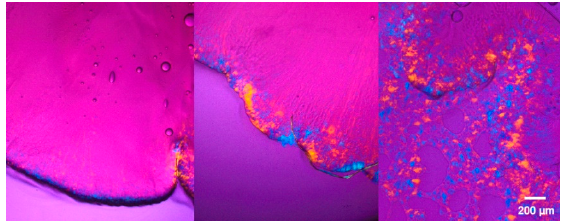
Figure 4. Polarized light microscopy of a lyotropic liquid crystalline phase, developing at the interface of SMEDDS (emerging from the top) and PBS when liquids are brought into contact. Photographs were taken over of the course of 30 s.